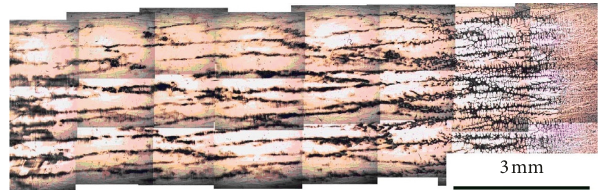
Figure 2: The macrostructure of part of the 30 μ m/s withdrawn DS ingot showing the columnar structure (left) and dendritic structure